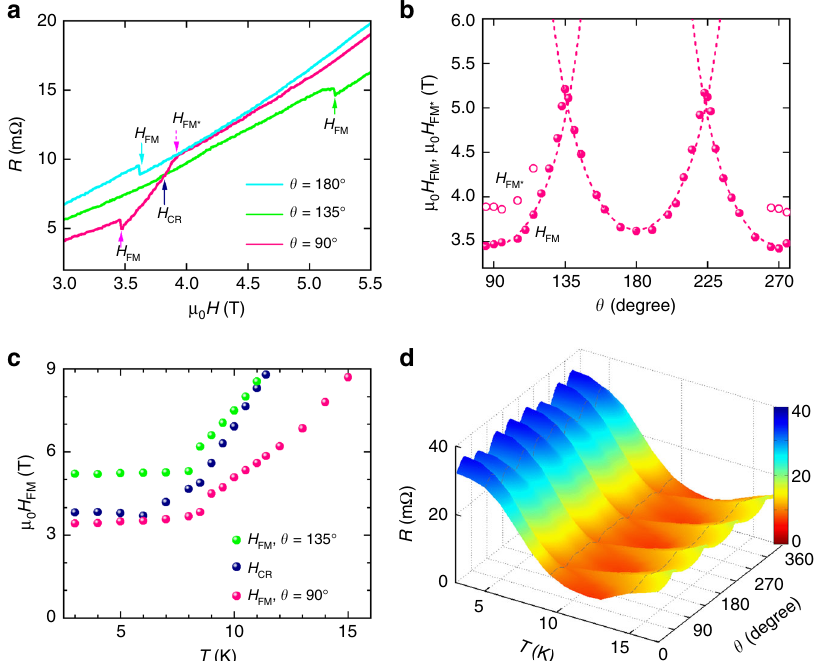
Fig. 2 Anisotropy of the ferromagnetic transition. a R ( Η ) curves of Sample A at T = 3K and θ = 90°, 135° and 180°. H FM is the magnetic fi eld above which the system is in the ferromagnetic state. H FM* indicates a possible phase transition. H CR is the magnetic fi eld above which the magnetoresistance at H k <011> is smaller than that at H k [010] and H k [00 (cid:1) 1]. b Angle dependence of H FM (solid symbols) and H FM* (open symbols). The dashed lines represent 1/ cos φ with φ = θ − n π / 2 with n = 1, 2, and 3 for 90° ≤ θ ≤ 135° and 135° ≤ θ ≤ 225°, and 225° ≤ θ ≤ 270°, respectively (see text for more discussion). c Phase diagrams H for the ferromagnetic states at H k [010] and H k [011] and for H CR, above which orbital- fl ops appear as clear magnetoresistance minima in the R ( θ ) curves. Results indicate that orbital- fl op effect is most pronounced in the ferromagnetic phase. d , Magnetoresistances at μ 0 H = 7T and temperatures from 3K to 25K. Orbital- fl op induced minima can be seen at θ = 45°, 135°, 225° and 315°, i.e., H k <011>at T